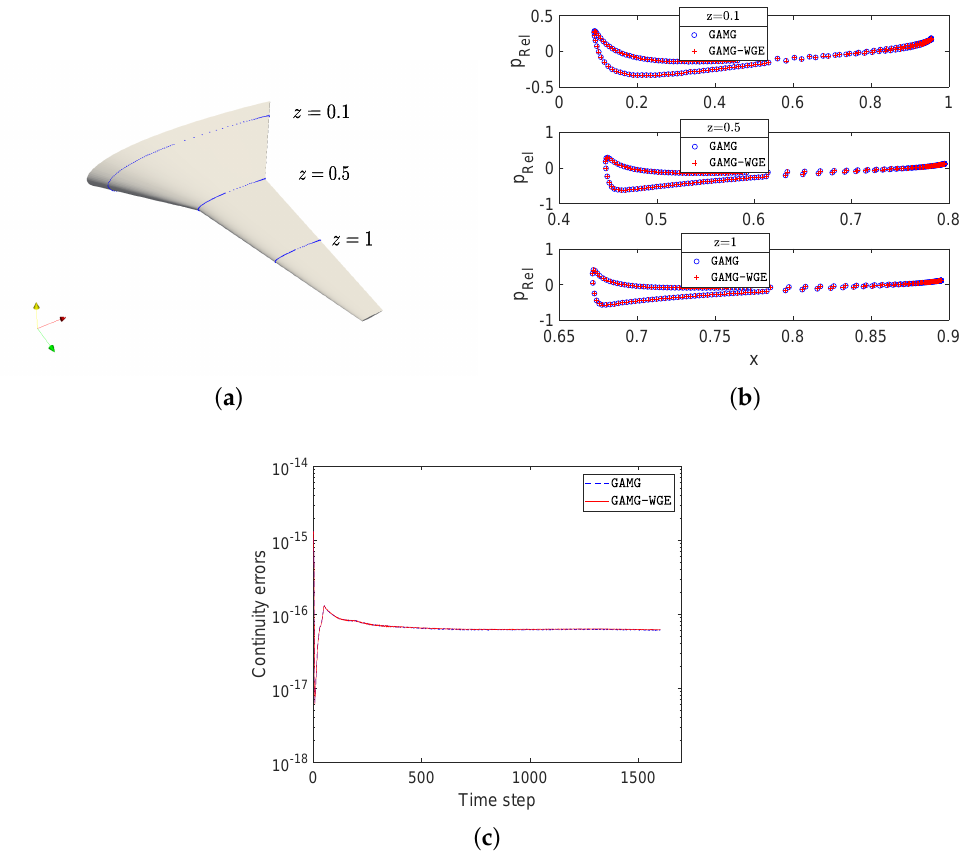
Figure 16. ( a ) The probe locations on the cross-sections of the airfoil, ( b ) the corresponding p Rel field at 0.1 s, and ( c ) the continuity errors using different methods in 3D blended-wing-body